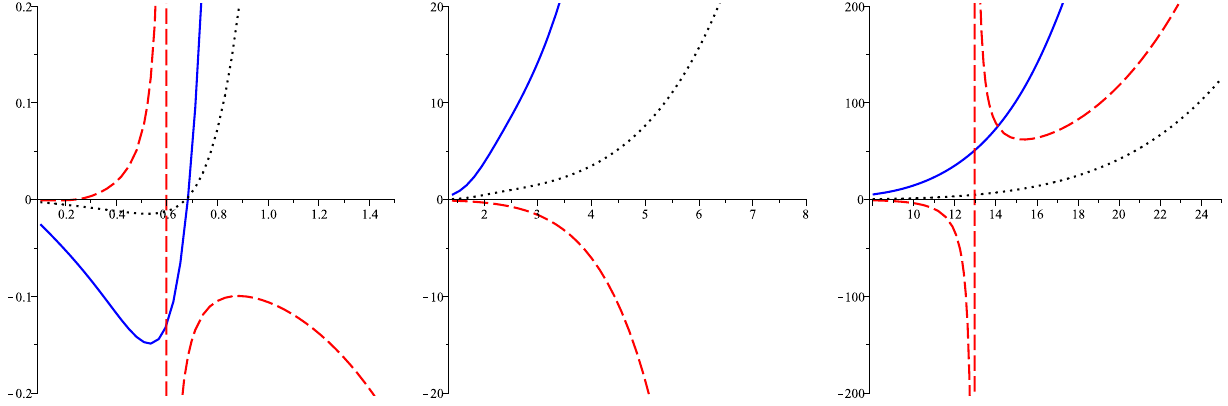
Fig. 8 C P , X versus r + for k = 1, d = 7, q = 1, α = 1, P = 1 / 8 π , m = 0 . 1, c 1 = c 2 = c 3 = c 4 = 1 and c 0 = 0 . 1 (solid line), c 0 = 1 (dotted i line) and c 0 = 10 (dashed line). Different scales: left panel (0 < r + < 1 . 5), middle panel (1 . 4 < r + < 8) and right panel (8 < r + < 25)